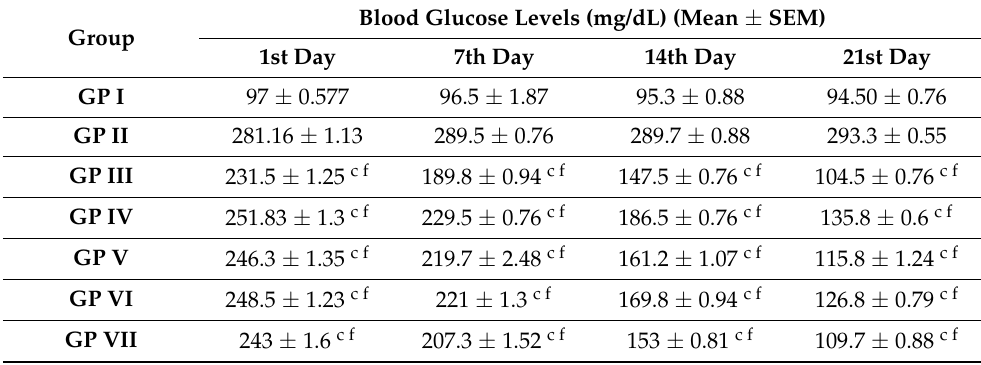
Table 1. Effect of P. guajava on blood glucose level in STZ-induced diabetic rats.